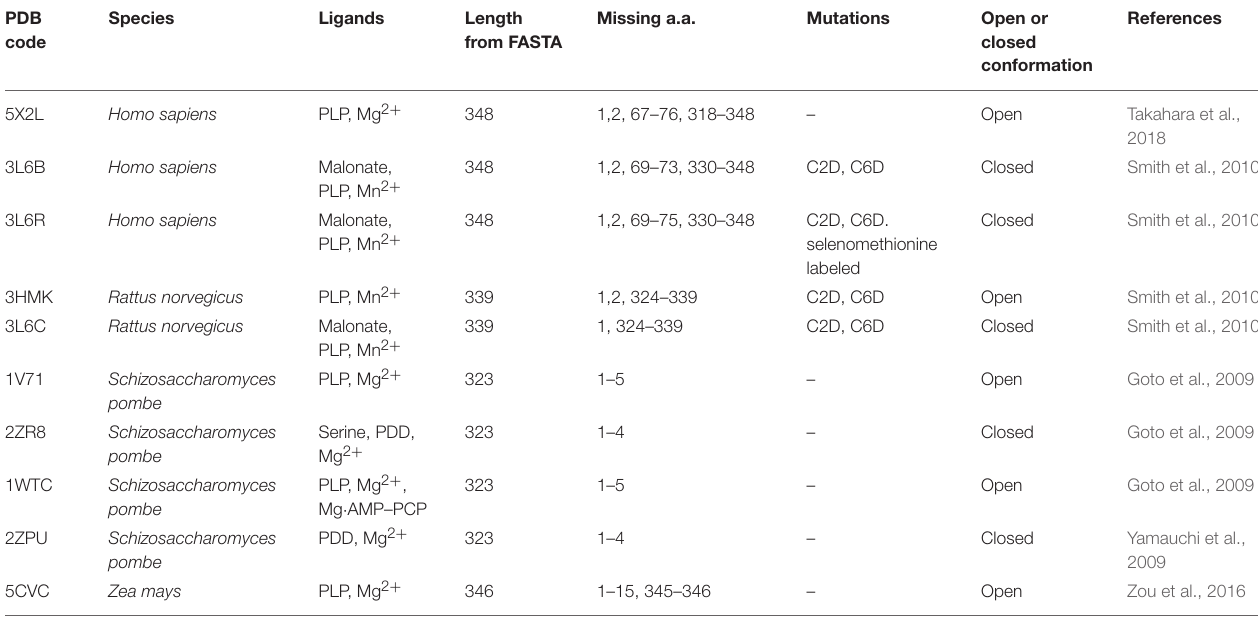
TABLE 1 | Structures of serine racemase available in the